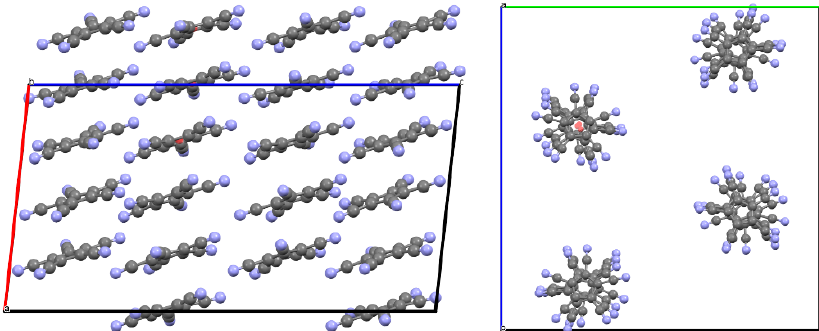
Figure 12. The π stacking of the anions, watched along b ( left ) and along a ( right ).